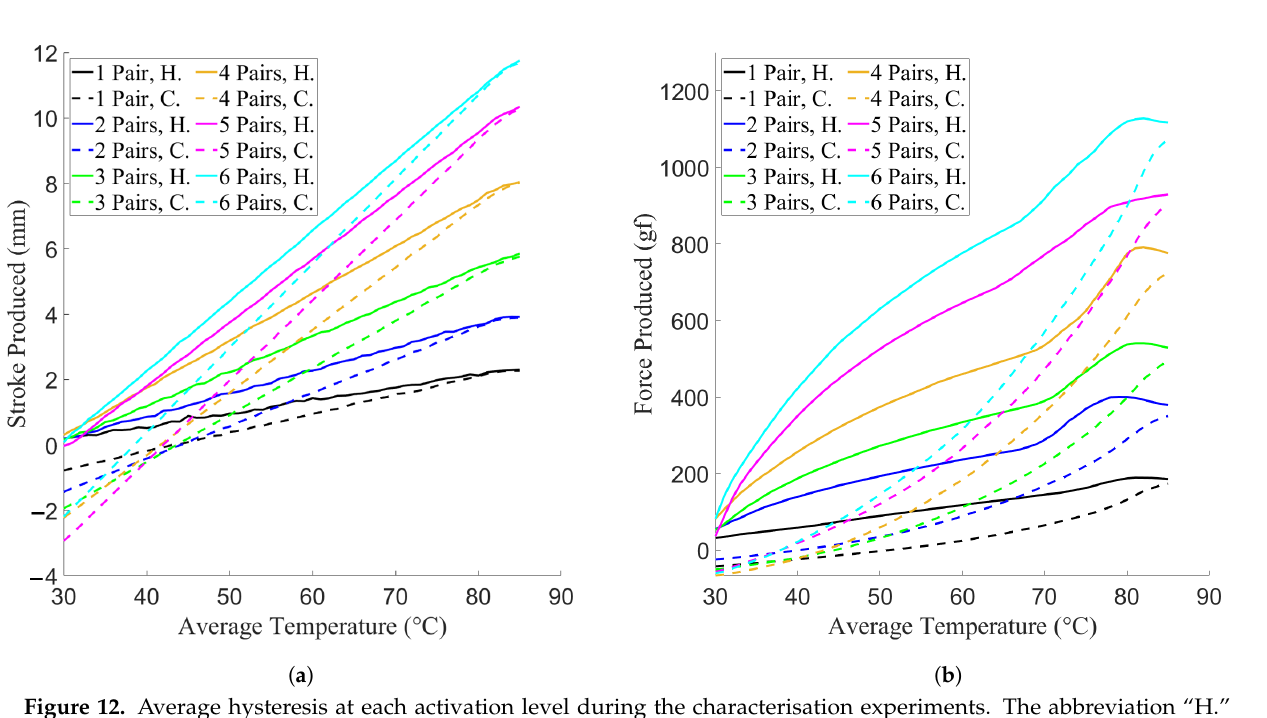
Figure 12. Average hysteresis at each activation level during the characterisation experiments. The abbreviation “H.” denotes the production of the actuator while it is heating, and the abbreviation “C.” denotes the production of the actuator while it is cooling. ( a ) Stroke production hysteresis curves. ( b ) Force production hysteresis curves.